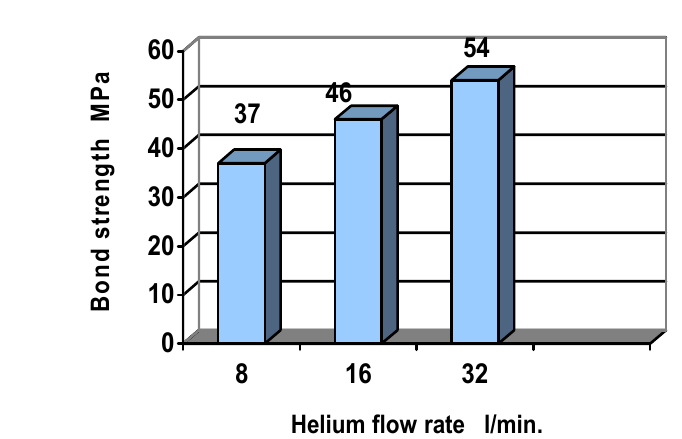
Figure 3 – Bond strength of WC – 12 wt.%Co layers Slika 3 – Č vrsto ć a spoja WC – 12tež. %Co